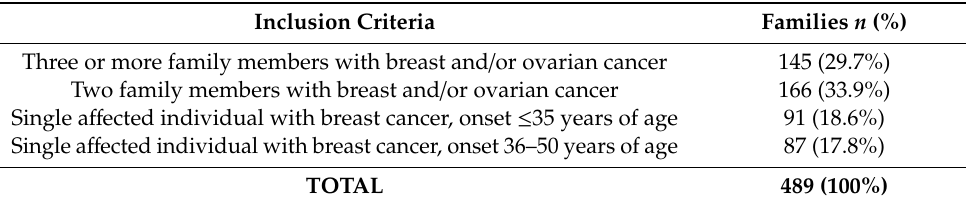
Table 5. Inclusion criteria for the families included in this